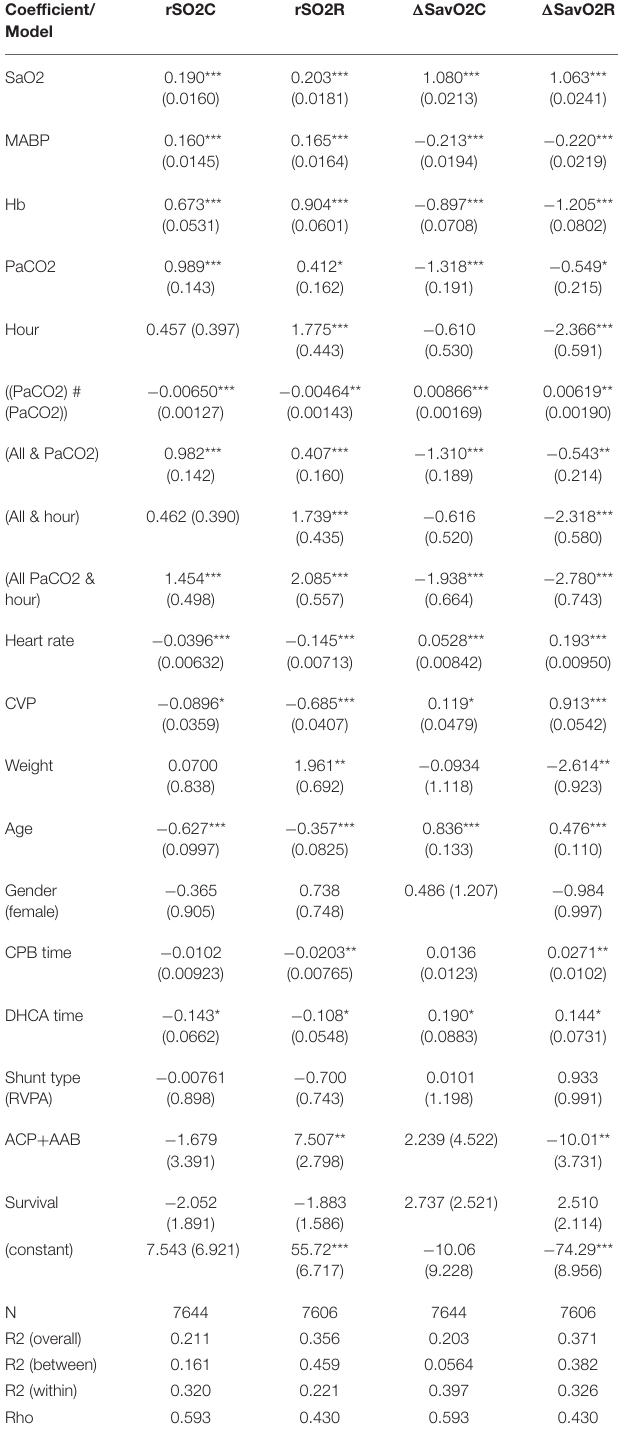
TABLE 4 | Multivariable regression results. Coefficient/